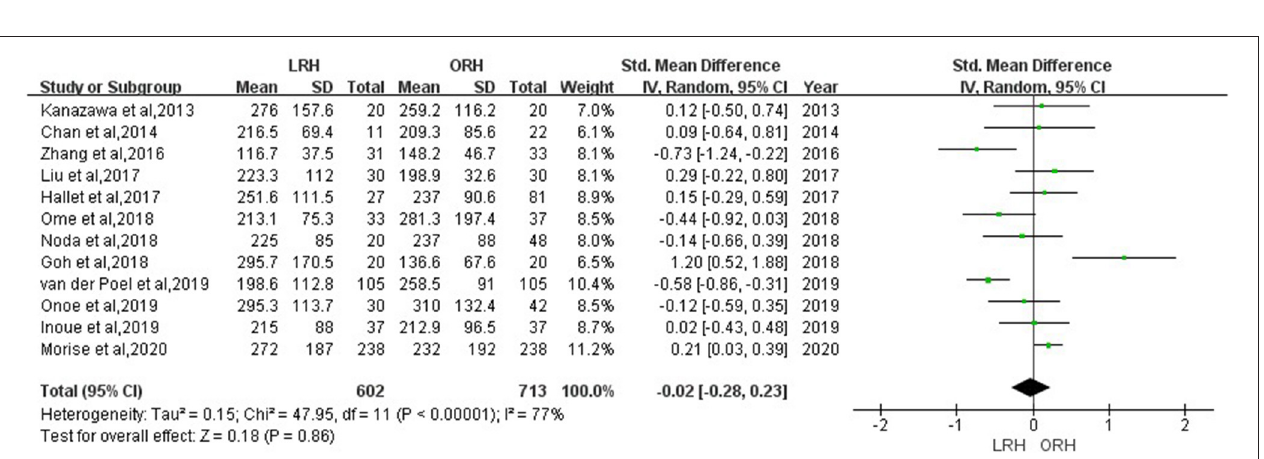
FIGURE 7 | Forest plots comparing operation time between LRH group and ORH group.